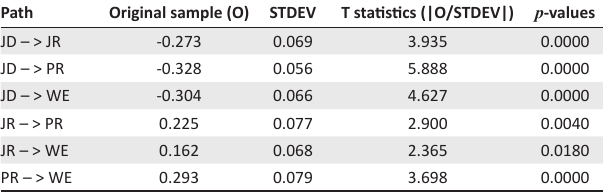
TABLE 5: Path coefficients.